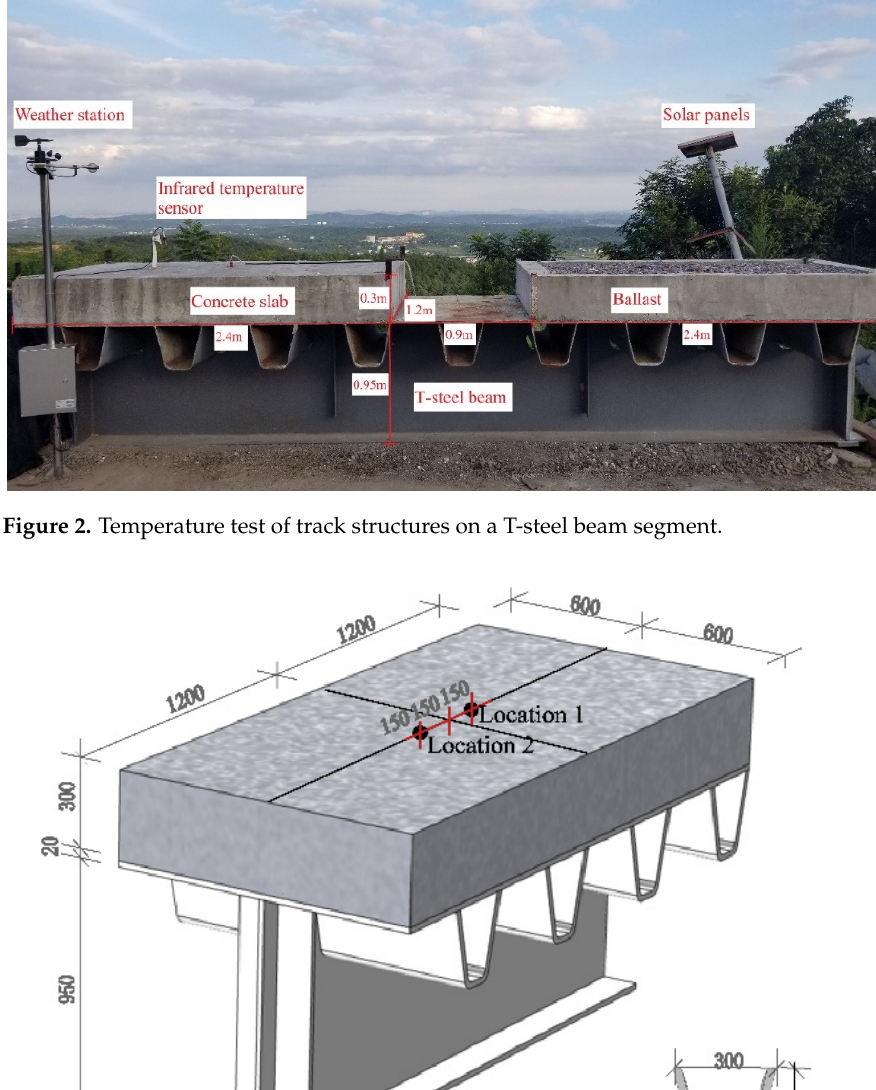
Figure 3. Geometric dimensions and measuring positions of the testing specimen (unit: mm).